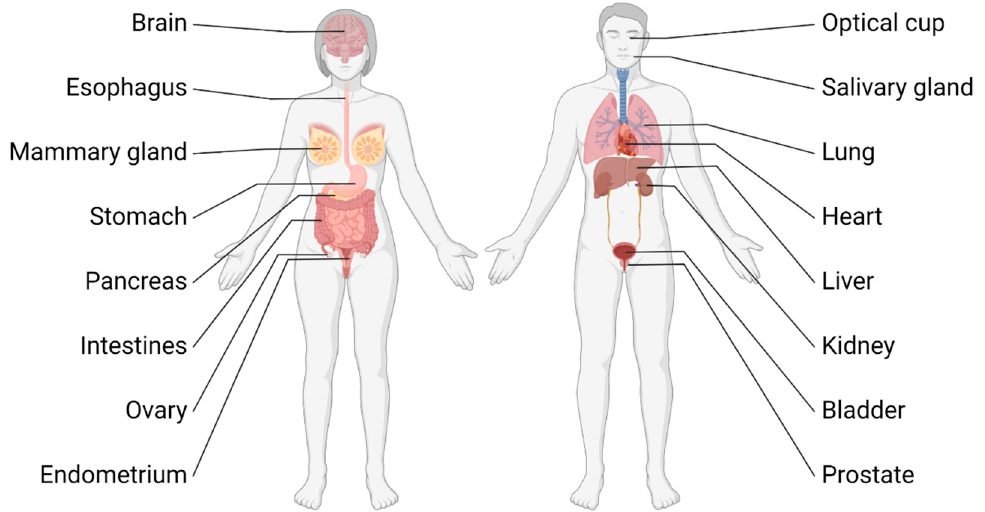
Figure 1. Overview of organs and tissues from which organoid cultures were generated.